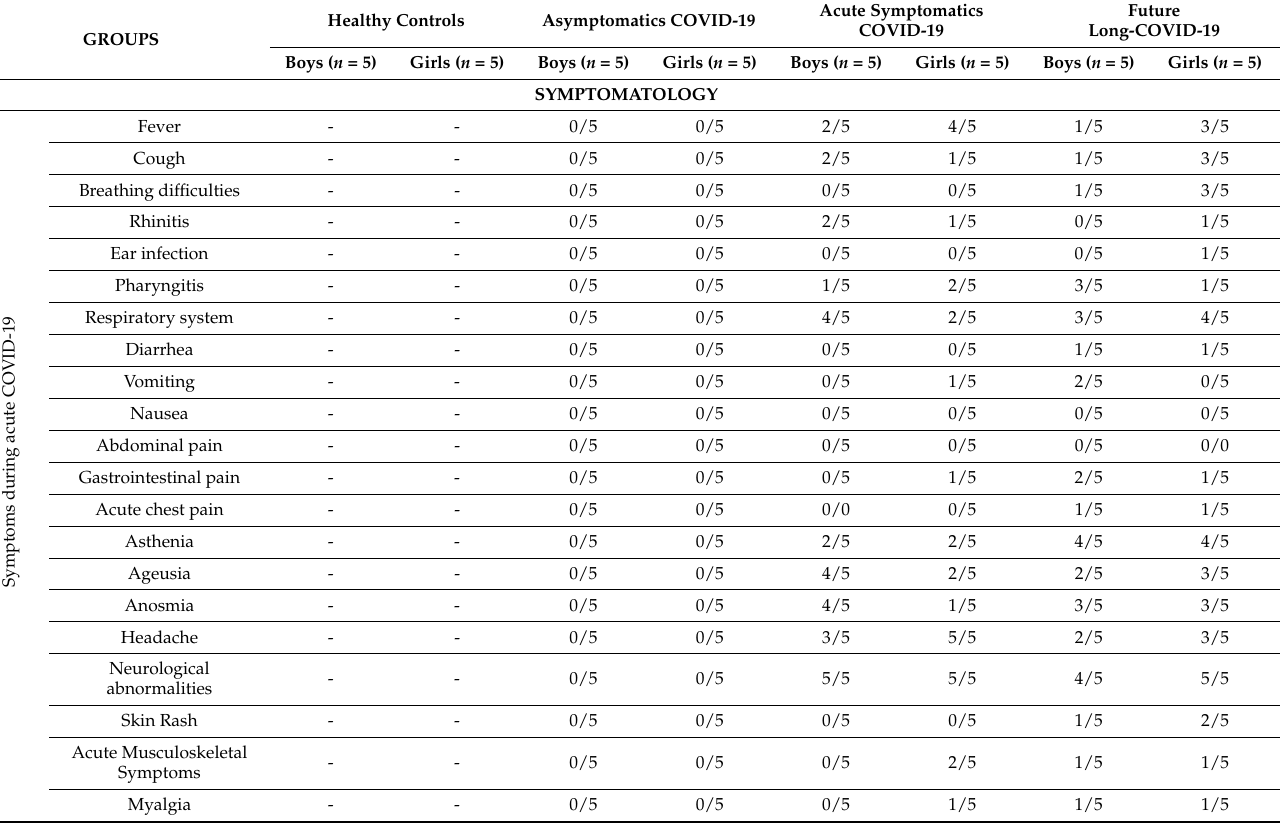
Table 1. Symptoms during the acute phase of COVID-19 disease in all 40 adolescents enrolled in the study. The number of cases vs. total patients was reported for each symptom. According to their COVID-19 related outcomes, recruited individuals were divided into 3 groups: asymptomatics, acute symptomatics, and acute symptomatics that over time developed long-COVID-19 symptoms (“future long-COVID-19”); as a control group, we analyzed the serum of age-matched healthy controls that did not contract the